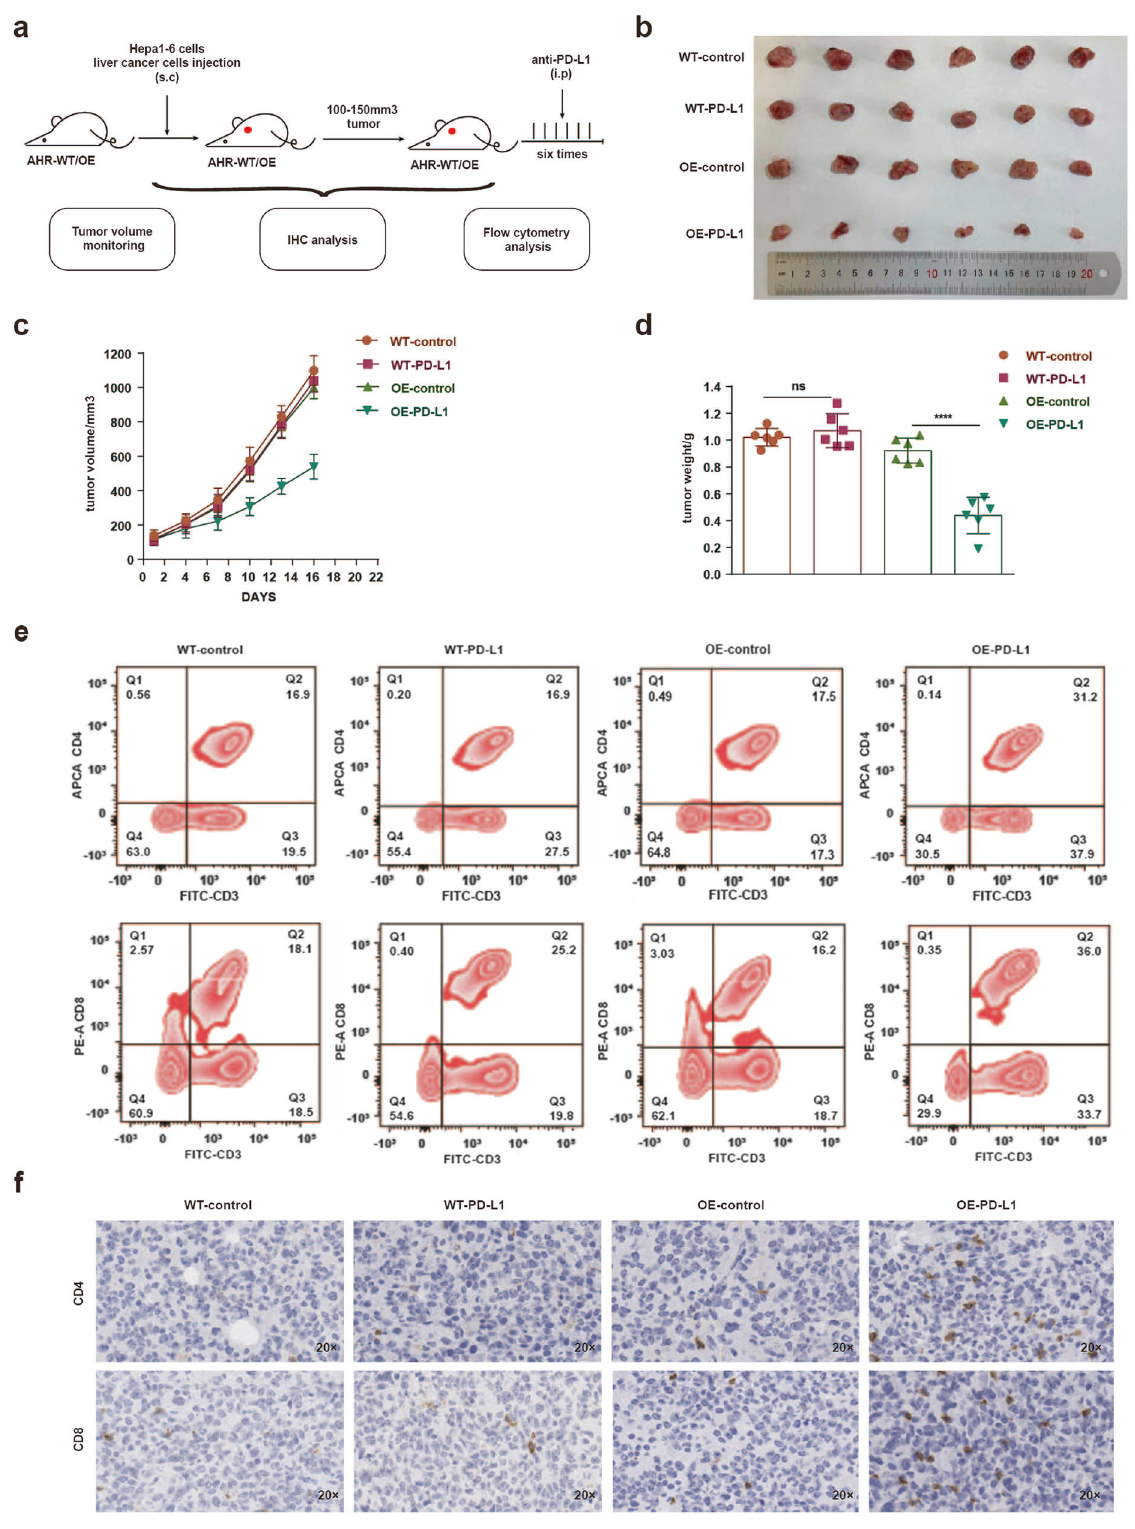
Fig. 7 Increased ef fi cacy of anti-PD-L1 therapy on liver cancer xenografts overexpressing AHR. a Schematic of the cycles anti-PD-L1 treatment of mice bearing liver tumor. b Representative images of xenograft tumors with anti-PD-L1 treatment. c Xenograft tumor volume plotted over days during anti-PD-L1 treatment. d Weight of xenograft tumors ( n = 6) harvested from animals after anti-PD-L1 treatment. e Flow cytometry assessing the proportion of CD4 + /CD8 + cells with fl uorescent antibodies against the cell markers indicated. f Immunohistochemical staining for CD4/8 in sections from xenograft tumors with or without anti-PD-L1